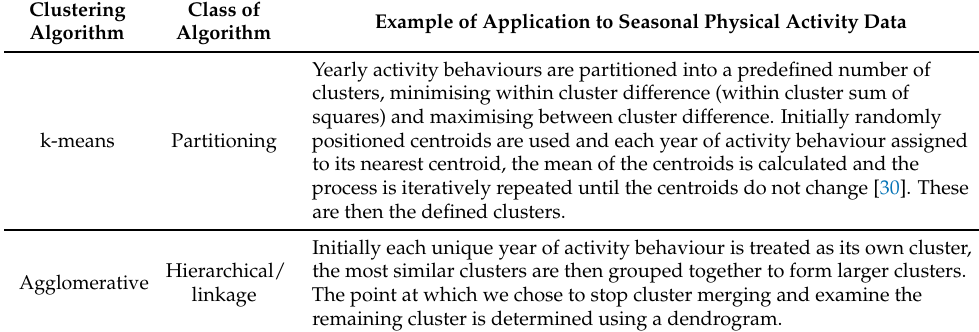
Table 1. Clustering method